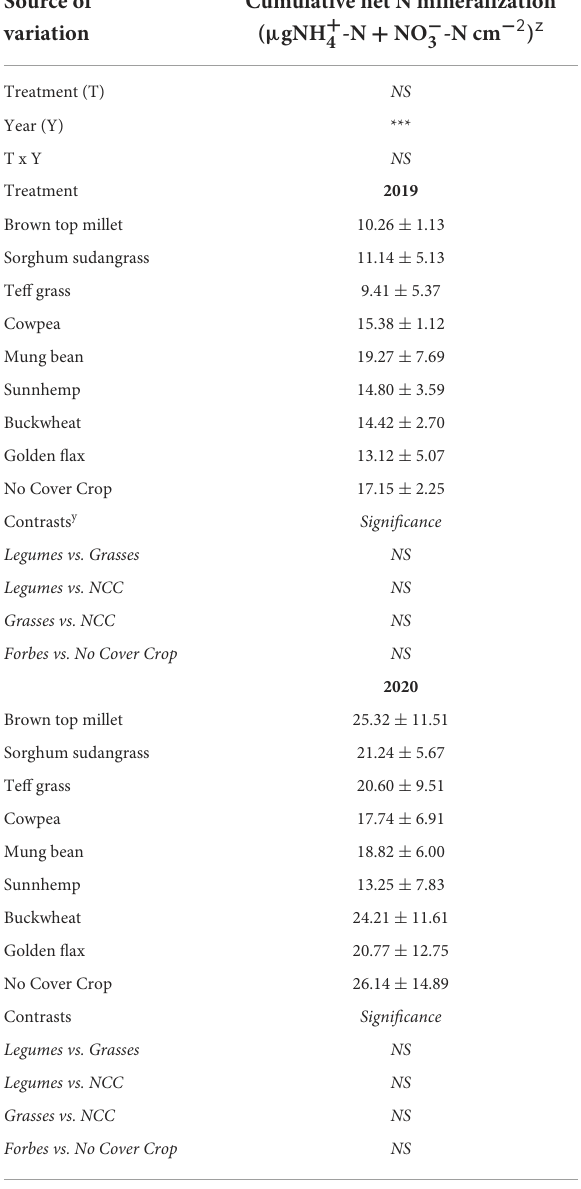
TABLE 6 Mean cumulative net N mineralization measure via inorganic N adsorbed to IEMs over a 6 week period following cover crop termination in cabbage